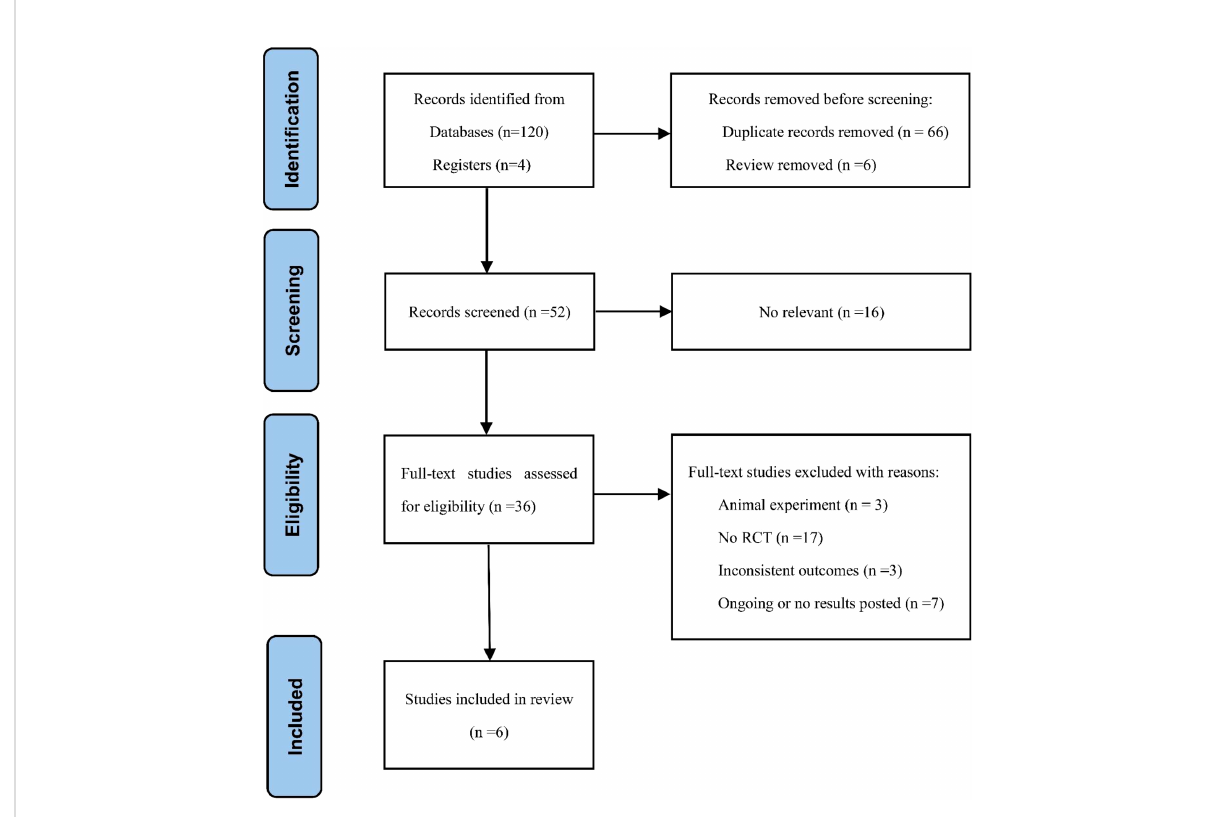
FIGURE 1 Flow chart of the literature selection